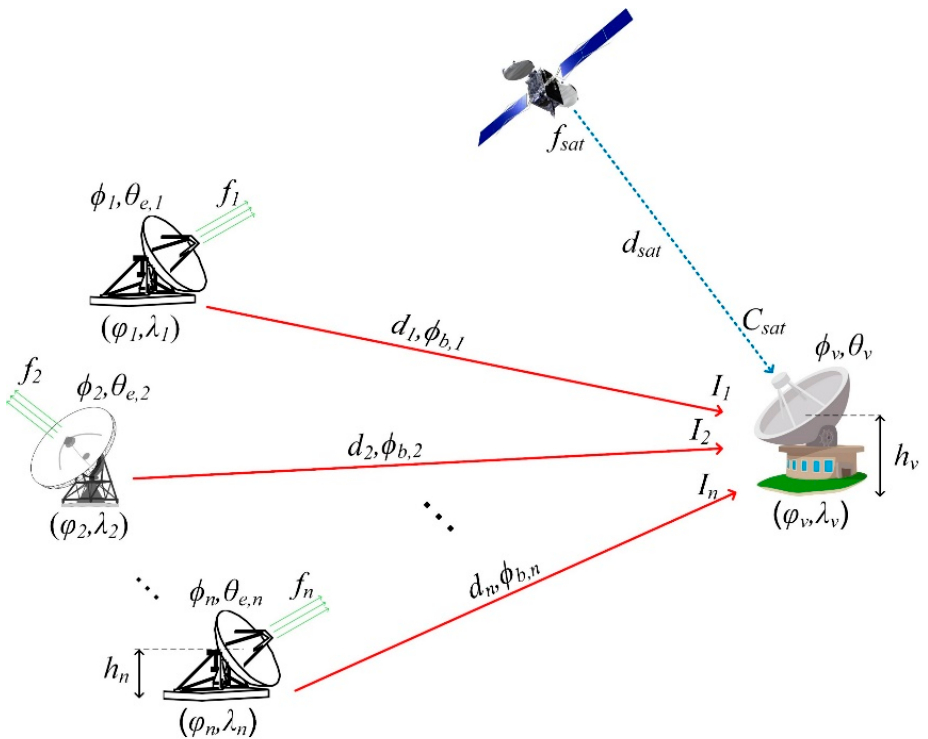
Figure 1. Ground-path interference scenario. The first step is to calculate the power of the carrier signal that arrives from the satellite to the victim station, which is determined using the fundamental transmission theory [10]